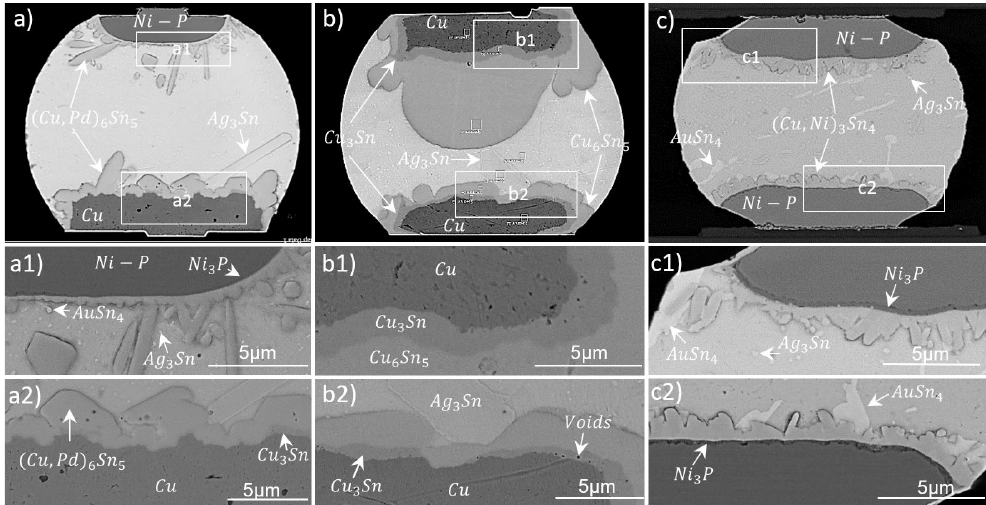
Figure 11. Cross-sections from the 30 µm bump-bond process showing an ENEPIG28-SAC-Cu30/100 (PLT) ( a ), a Cu30/100-SAC-Cu30/100 ( b ) and an ENIG30-SAC-ENIG30 ( c ) solder joint. Magnified views of upper and lower UBM interfaces for three samples are shown as ( a1 ), ( b1 ) and ( c1 ); and ( a2 ), ( b2 ) and ( c2 ),